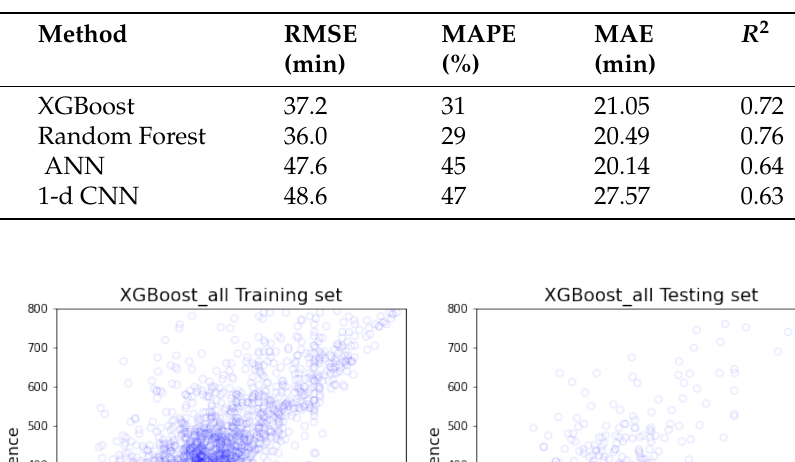
Table 2. Results of all-inclusive models.